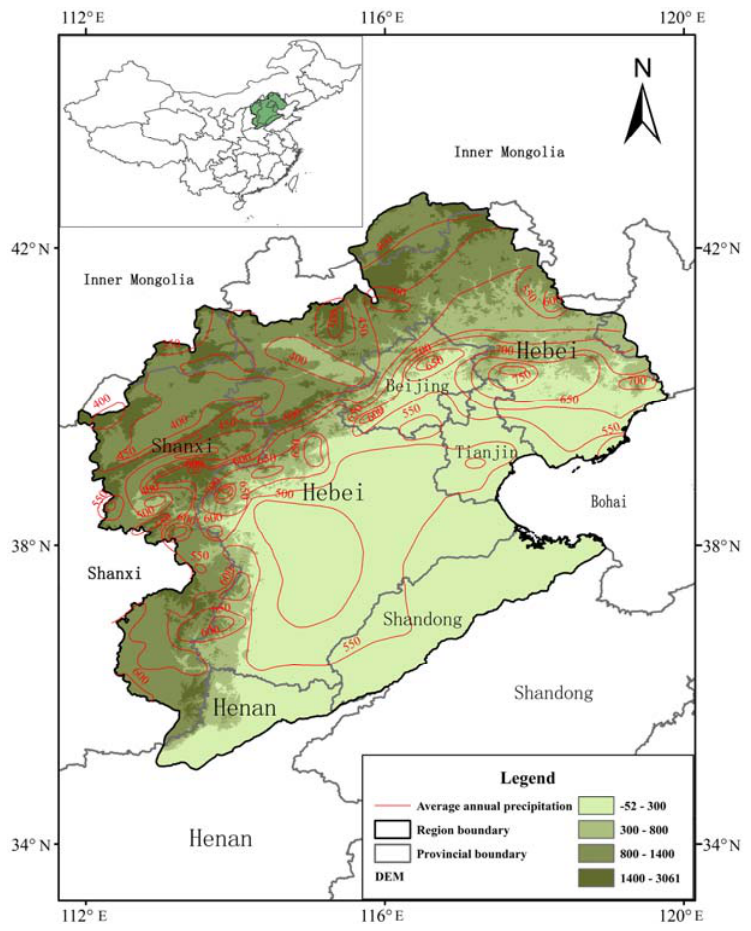
Figure 1. Location, topography and average annual precipitation contours (1960–2015) of the Haihe River Basin.